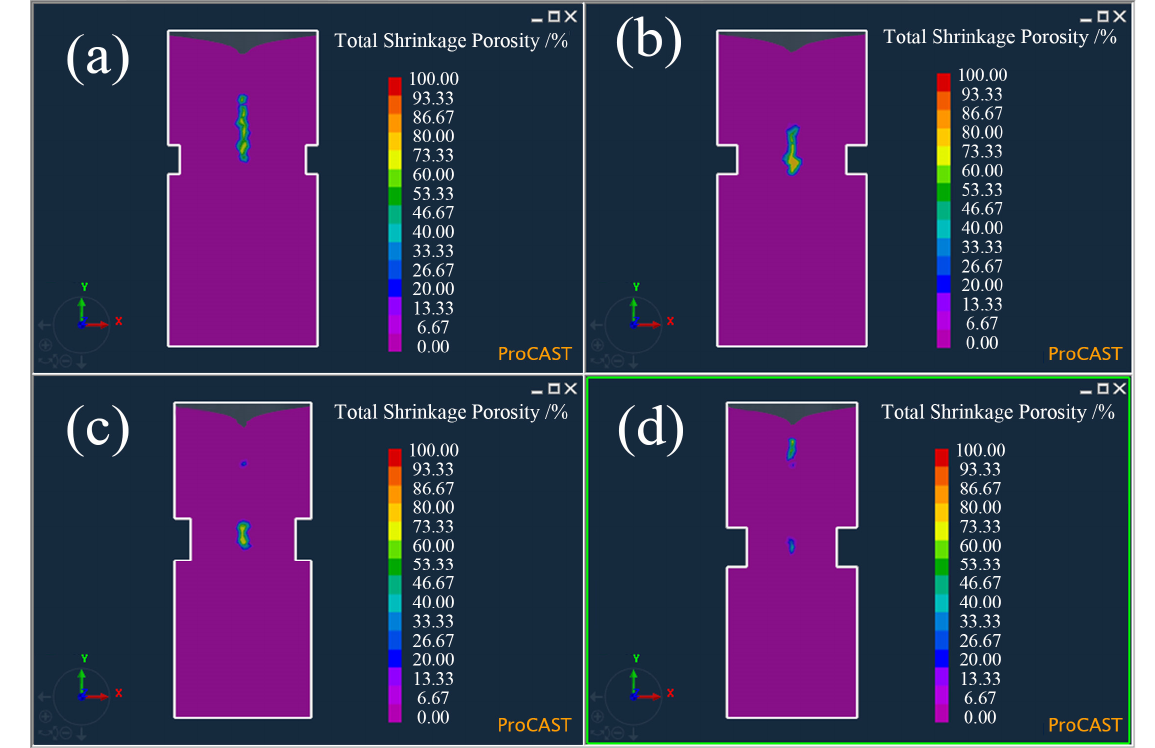
Figure 4. Shrinkage of the Ø26 × 55 mm sample with four different neck sizes by simulation: ( a ) No. 1 in Table 3, ( b ) No. 2 in Table 3, ( c ) No. 3 in Table 3, and ( d ) No. 4 in Table 3.